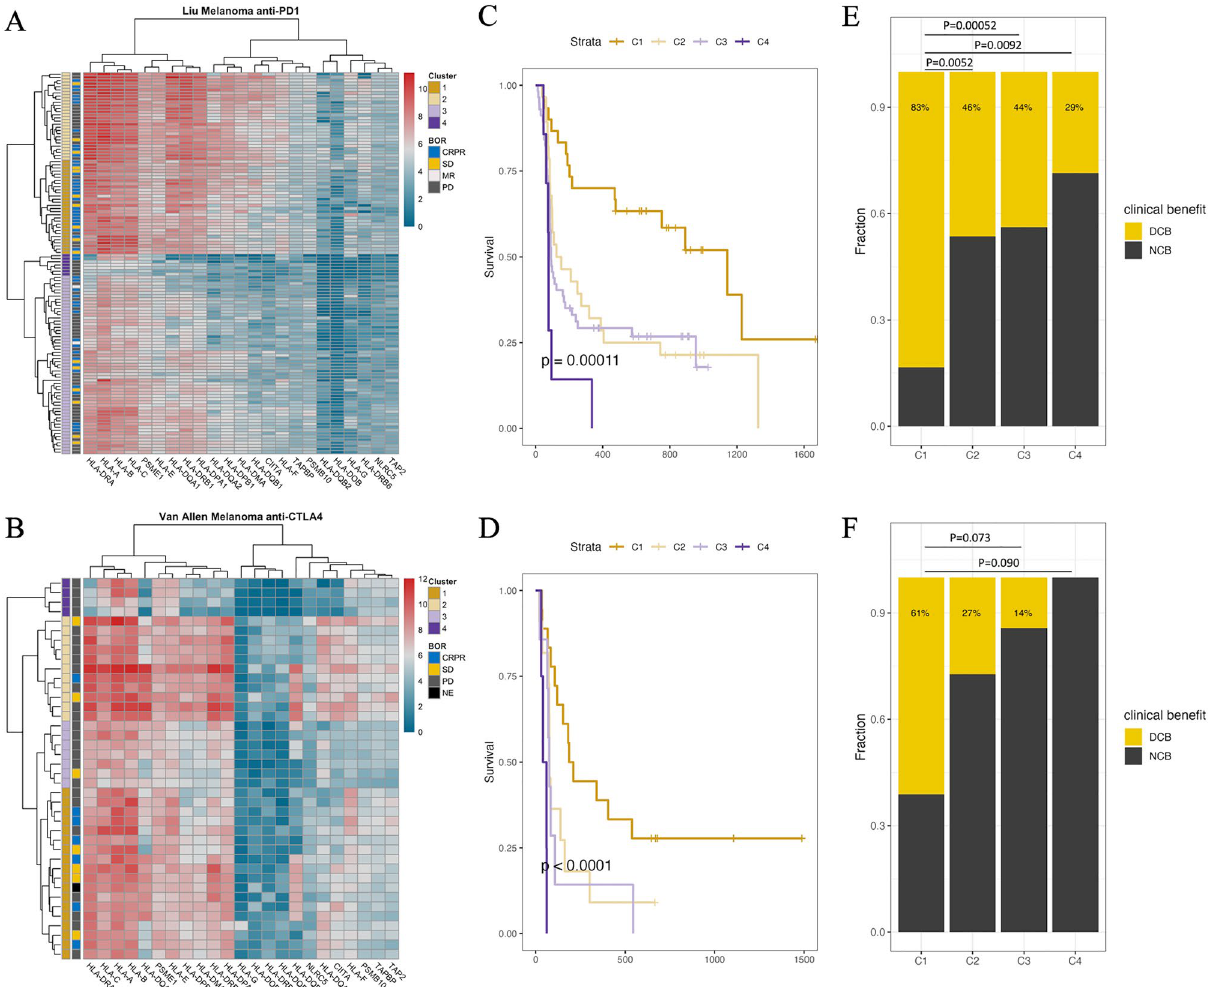
Figure 1. Unsupervised hierarchical clustering on APM genes correlates with patient survival. ( A,B) Independent clustering in the Liu melanoma anti-PD1 cohort (n = 122) ( A ) and Van Allen anti-CTLA4 cohort (n = 40) ( B ) (discovery cohorts) using the trained APM gene signature. pheatmap function in pheatmap version 1.0.12 (https:// www. rdocu menta tion. org/ packa ges/ pheat map/ versi ons/1. 0. 12) was used to generate the heatmaps. Each row represents a patient, and each column represents a gene. Gene expression is represented as log transformed transcripts per million (TPM) reads. BOR best overall response, CRPR complete/partial response, SD stable disease, MR mixed response, PD progressive disease. ( C,D ) Progression-free survival (PFS) stratified by the APM clusters in the Liu cohort (C1: n = 30, C2: n = 28, C3: n = 57, C4: n = 7) ( C ) and Van Allen cohort (C1: n = 18, C2: n = 11, C3: n = 7, C4: n = 4) ( D ) represented as Kaplan–Meier curves. P-value was computed by Log-rank test. ( E–F ) Proportion of patients with DCB versus NCB across the APM clusters in the Liu cohort ( E ) and Van Allen cohort ( F ). Percentage indicates fraction of patients with DCB within the cluster. Significance was calculated by two-sided Fisher’s exact test. DCB durable clinical benefit, NCB no clinical